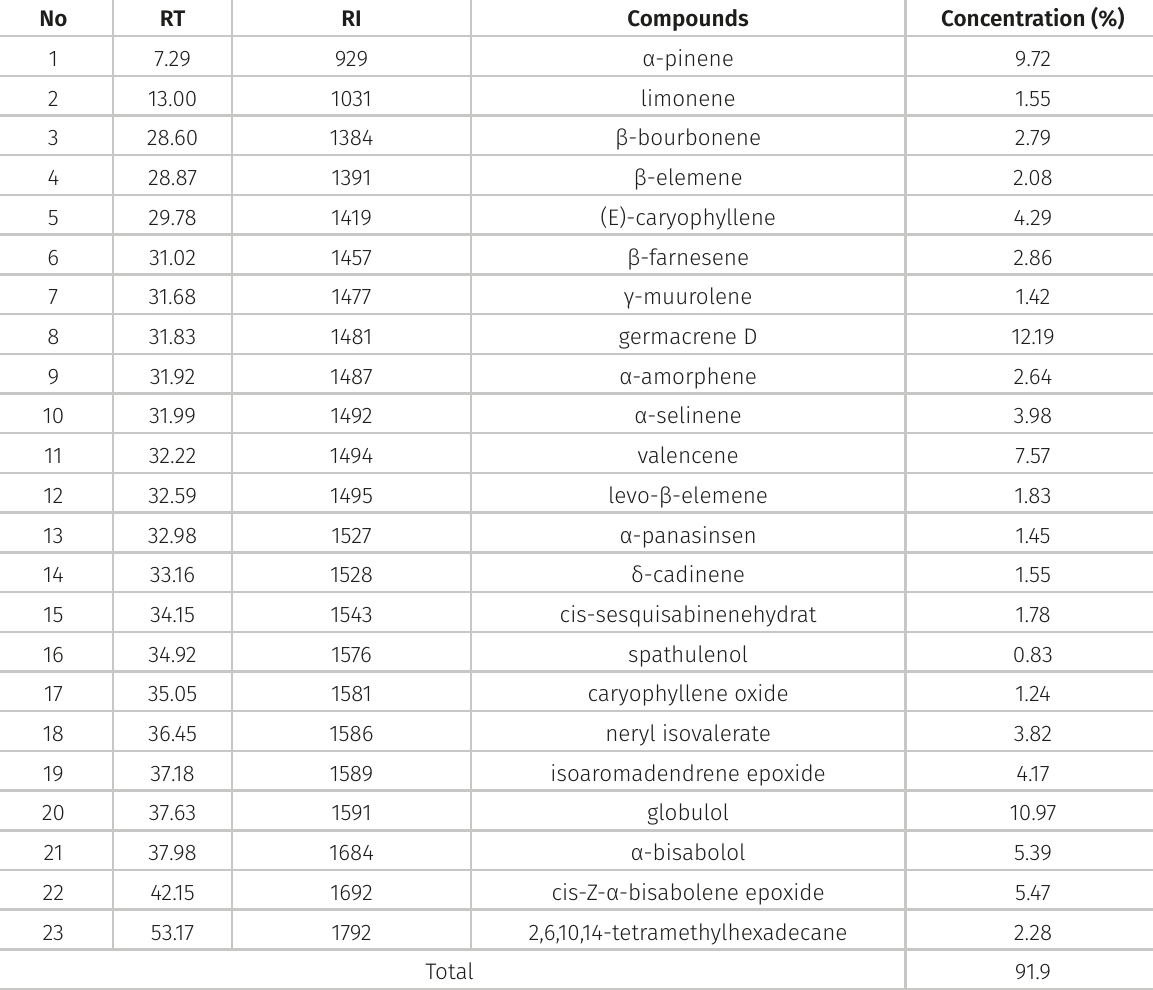
Table I. Chemical compositions of the essential oil of S. macrostachya. No RT